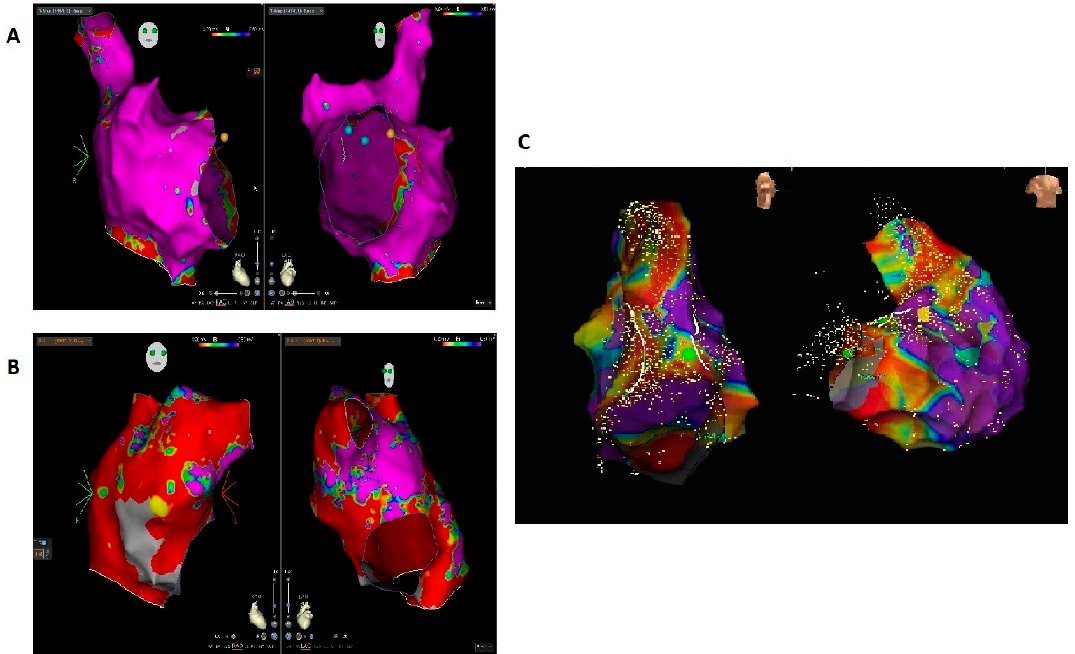
polar scar areas.